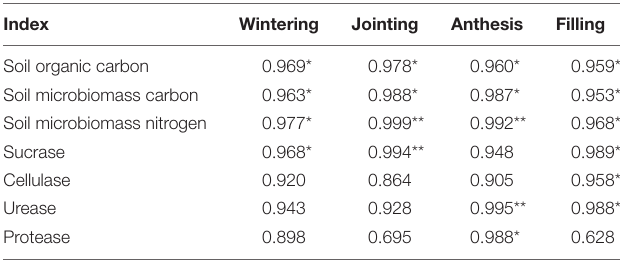
TABLE 4 | Relationships among yield of wheat and soil organic carbon, soil microbiomass carbon and nitrogen, and soil microorganisms enzyme activity.